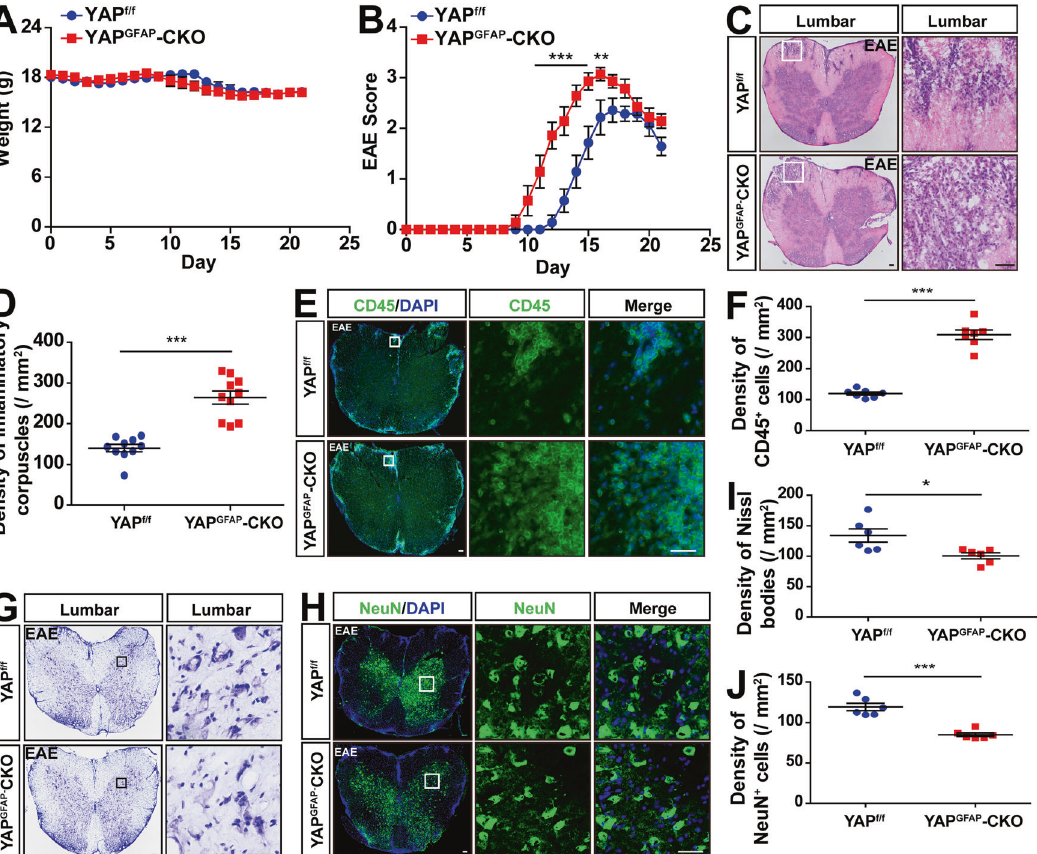
Fig. 2 Knockout YAP in astrocytes aggravated EAE. A The body weight of YAP f/f and YAP GFAP -CKO mice from 0 to 21 dpi during the EAE modeling process ( n = 7, two-way ANOVA with Bonferroni ’ s post-tests). B The EAE score of YAP f/f and YAP GFAP -CKO mice from 0 to 21 dpi during the EAE modeling process ( n = 7, two-way ANOVA with Bonferroni ’ s post-tests). C Representative images of HE staining in the lumbar spinal cords of YAP f/f and YAP GFAP -CKO EAE mice. D Quanti fi cation of the density of in fl ammatory corpuscles as shown in C ( n = 10). E Immunostaining of CD45 (green) in the lumbar spinal cords of YAP f/f and YAP GFAP -CKO EAE mice. F Quanti fi cation of the density of CD45 + cells as shown in E ( n = 7). G Representative images of Nissl ’ s staining in the lumbar spinal cords of YAP f/f and YAP GFAP -CKO EAE mice. H Immunostaining of NeuN (green) in the lumbar spinal cords of YAP f/f and YAP GFAP -CKO EAE mice. I Quanti fi cation of the density of Nissl bodies as shown in G ( n = 6). J Quanti fi cation of the density of NeuN + cells as shown in H ( n = 6). Scale bars, 50 μ m. Data were mean ± SEM. Student ’ s t -test unless otherwise indicated, * p < 0.05, ** p < 0.01, *** p <